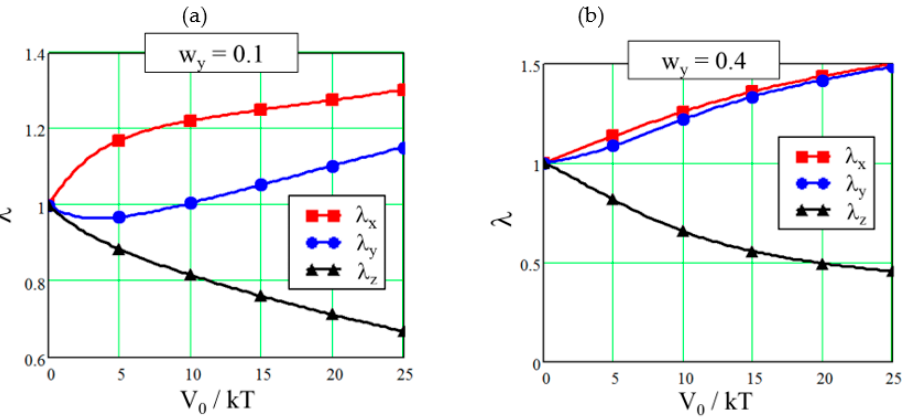
/kT at w y = 0.1 ( a ) and w y = 0.4 ( b ) 0 0